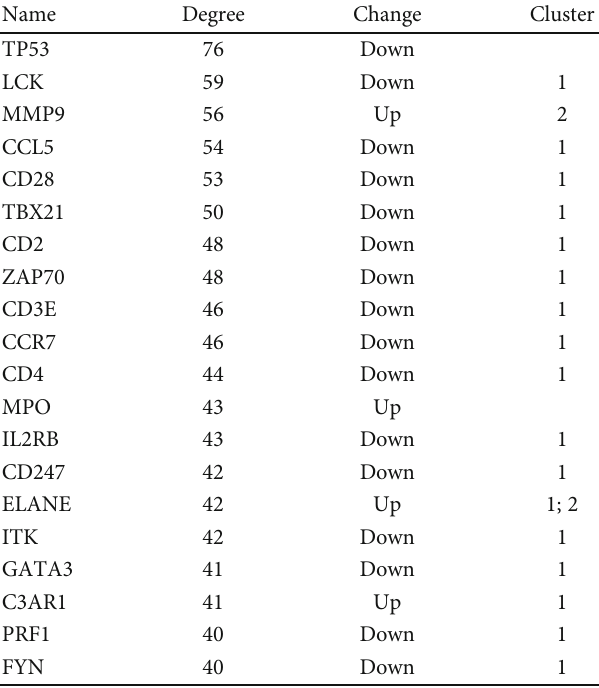
(a) The top 20 genes in the network ranked by